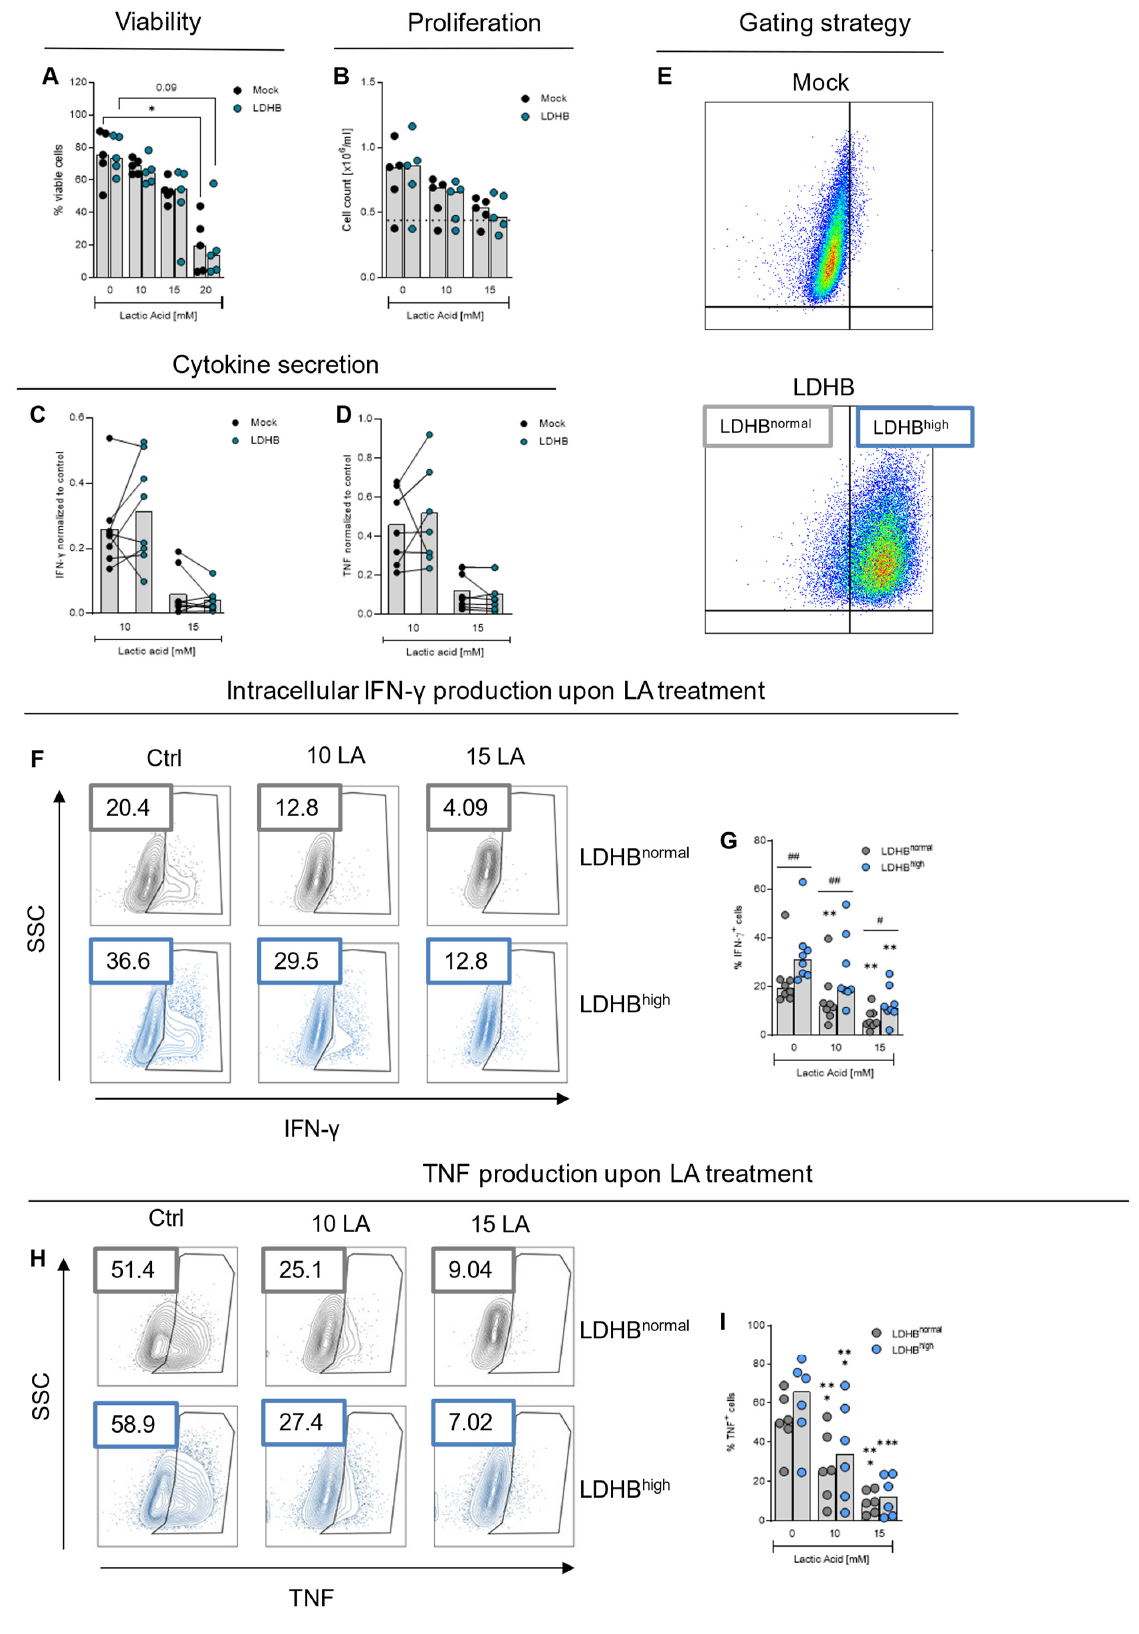
Figure 3. LDHB overexpression in human CD4 T cells mitigates lactic acid effect on cytokine production. ( A , B ) Cells were stimulated with α -CD3/CD28 coated beads in the presence of